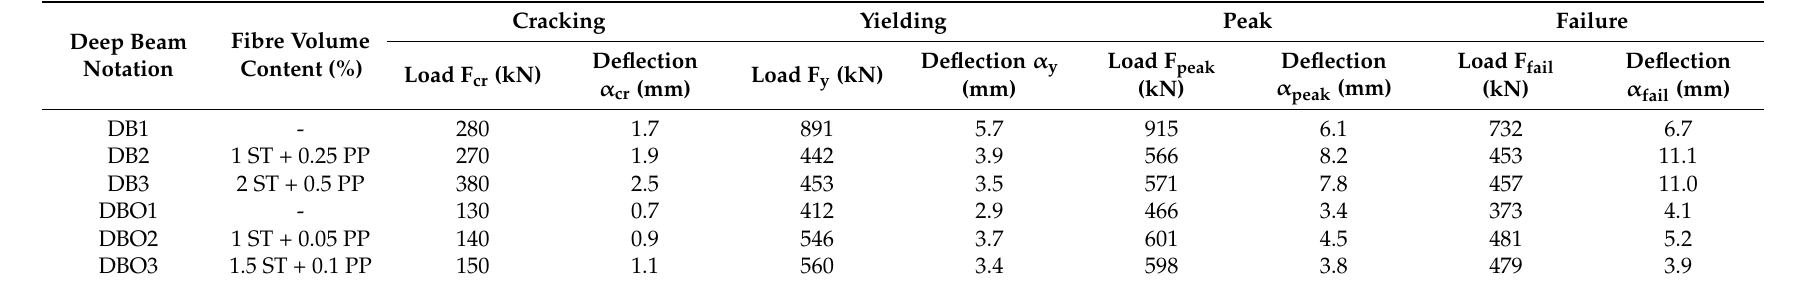
Table 4. Load-deflection response results of deep beams at cracking, yielding, peak and failure